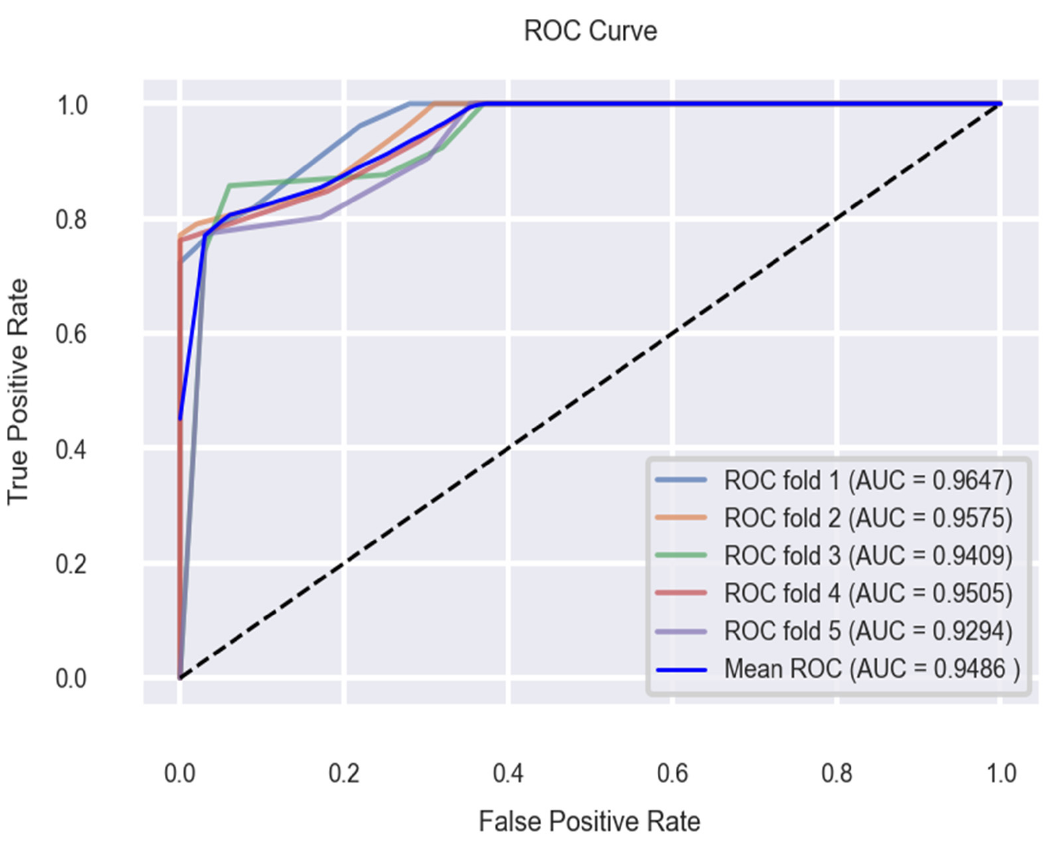
Figure 21. Stratified (K = 5)-Fold Cross-validation Results for KNN (ROC-AUC).